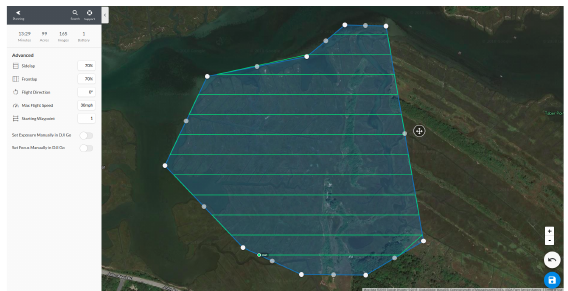
Figure 2. High Tide Drone Deploy Flight Plan